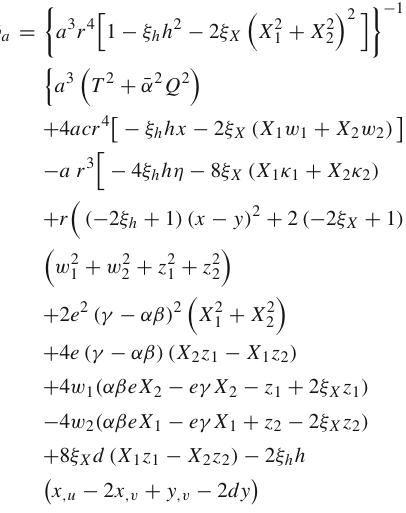
Fig. 3 The u -locations of the event horizons, u eh , radii, r eh , and masses, m eh , of black holes formed during the gravitational collapse H with scalars minimally coupled to gravity as functions of a m 2 , b α m ,